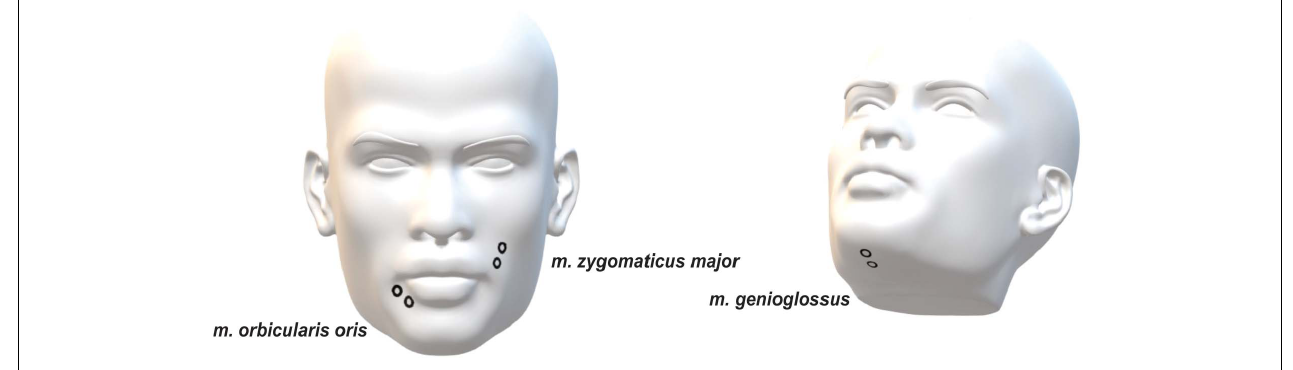
FIGURE 1 | Placement of EMG